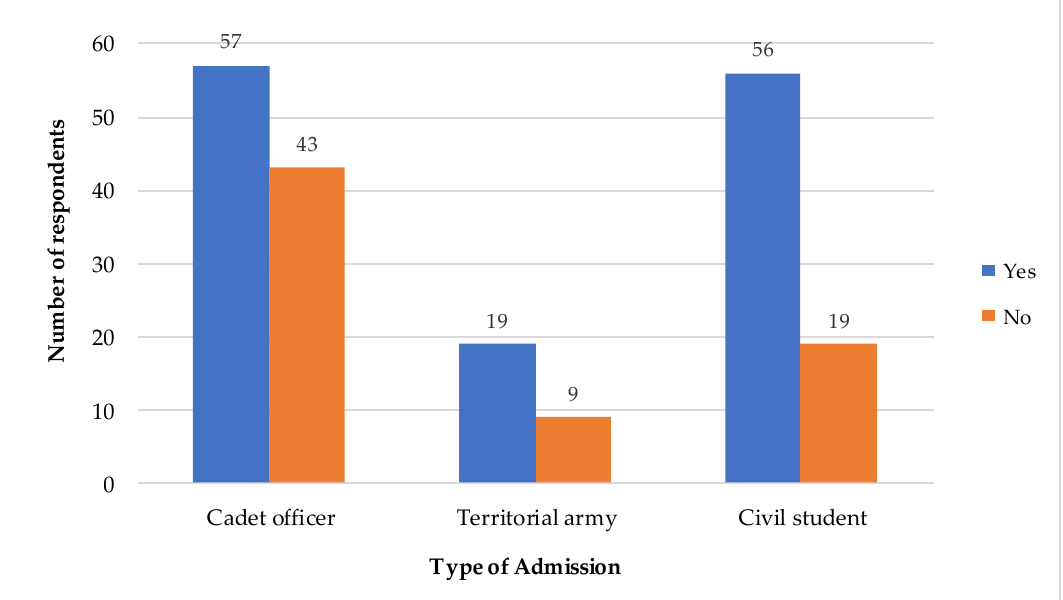
Figure 3. Distribution of use of antibiotic in the previous year within different types of admission ( n = 204).